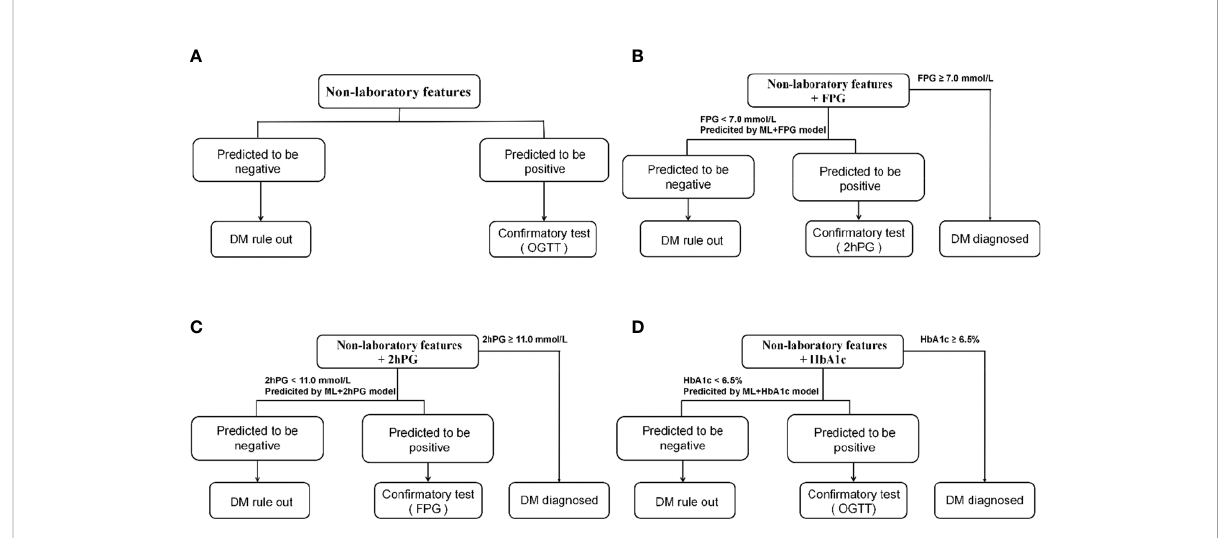
FIGURE 2 Diabetes detection procedures of models. (A) , Detection procedures of ML model and NCDRS. (B) , Detection procedures of ML+FPG model and NCDRS+FPG model. (C) , Detection procedures of ML+2hPG model and NCDRS+2hPG model. (D) , Detection procedures of ML+HbA1c model and NCDRS+HbA1c model. OGTT in a and d included fasting plasma glucose and 2h post-load plasma glucose. NCDRS, New Chinese Diabetes Risk Score; DM, diabetes mellitus; OGTT, oral glucose tolerance test; FPG, fasting plasma glucose; 2hPG, OGTT-2h post-load plasma glucose, HbA1c, glycated hemoglobin